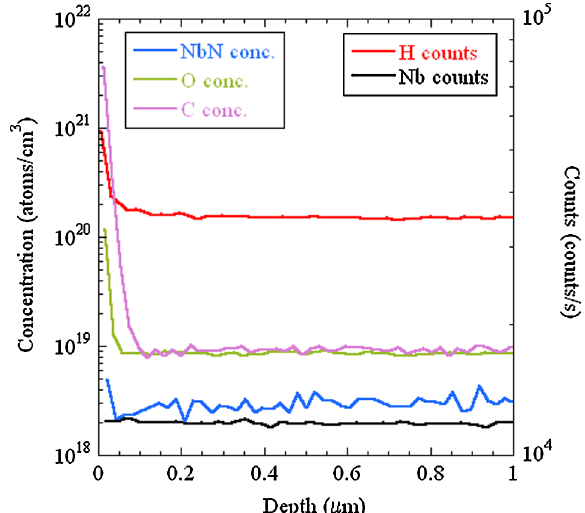
FIG. 28. (Color) SIMS reduced data depth profile for electro-